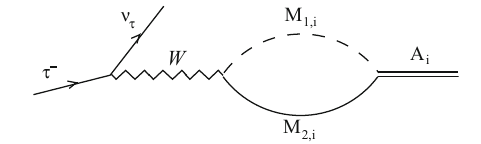
Fig. 3 Mechanism for the production of the dynamically generated axial-vector resonance A i through the coupled channels M 1 , i , M 2 , i , of pseudoscalar and vector mesons